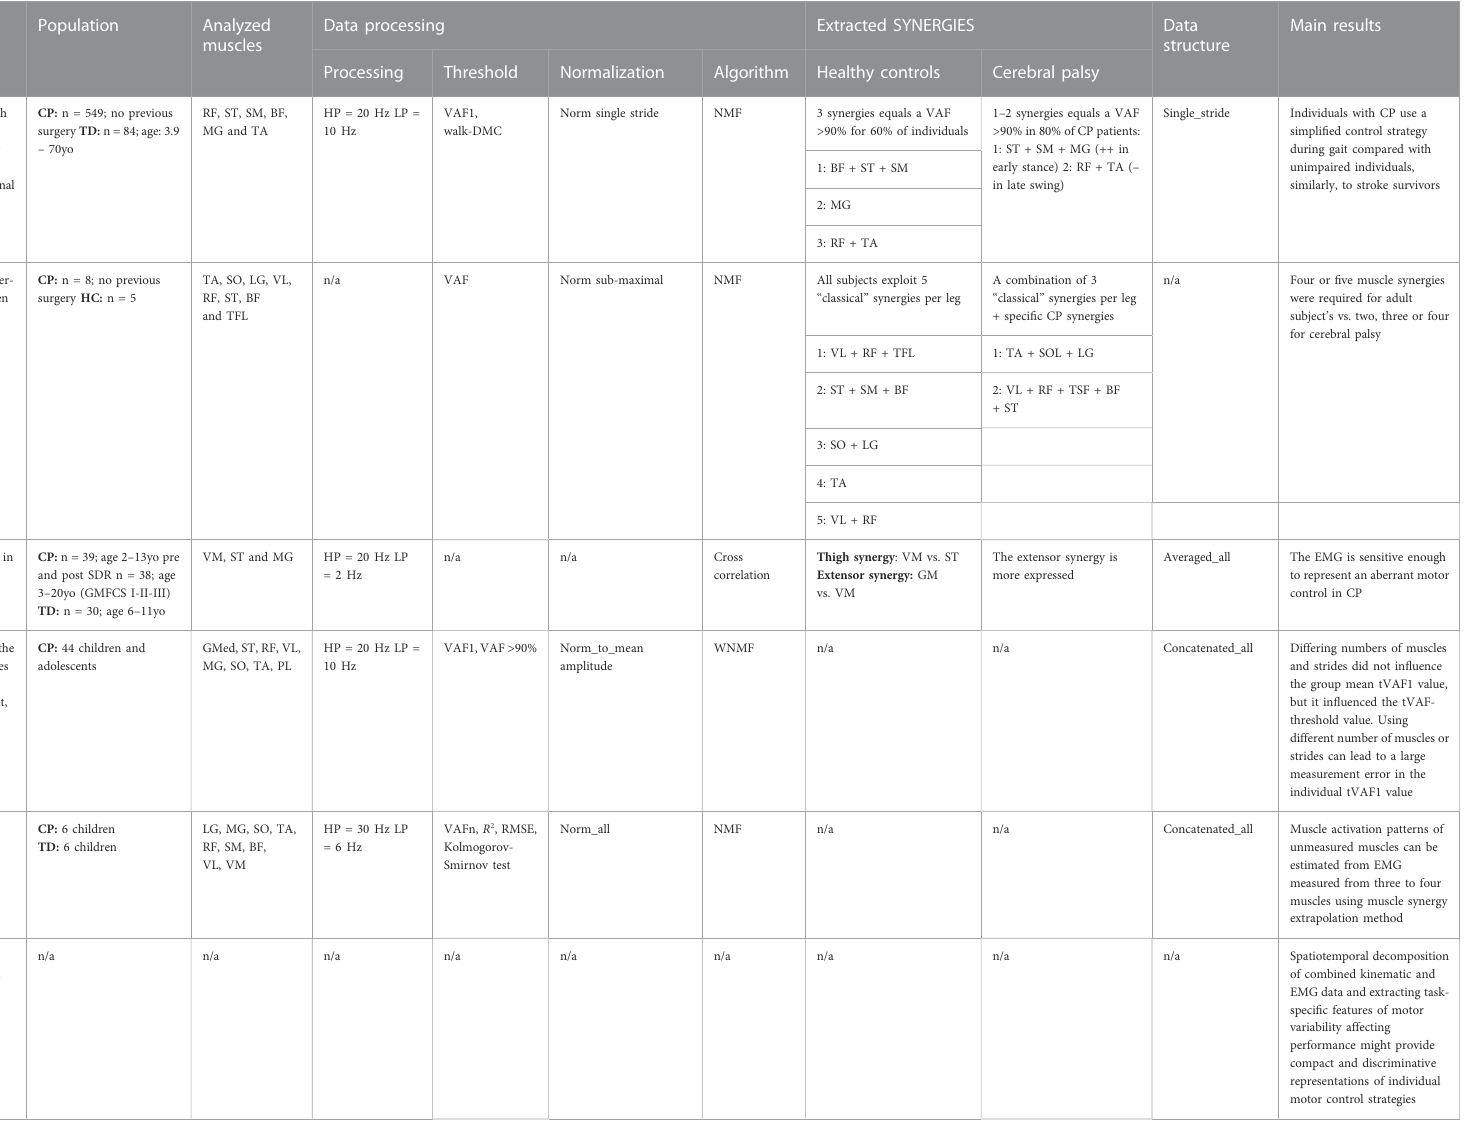
Cross correlation